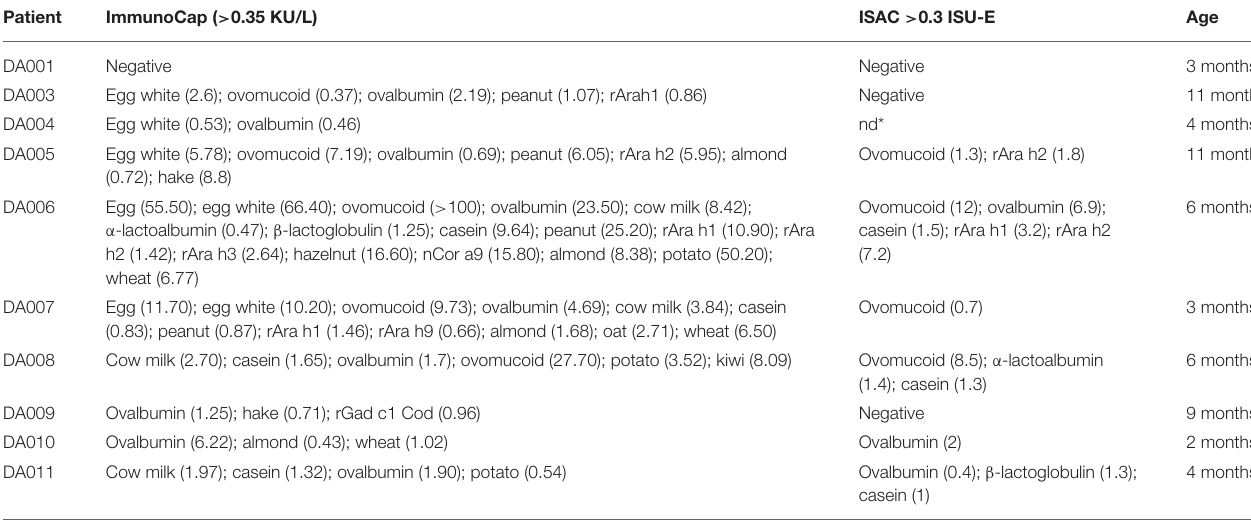
TABLE 1 | sIgEs determined by ImmunoCAP FEIA and ISAC in infants with moderate-to-severe AD. Patient